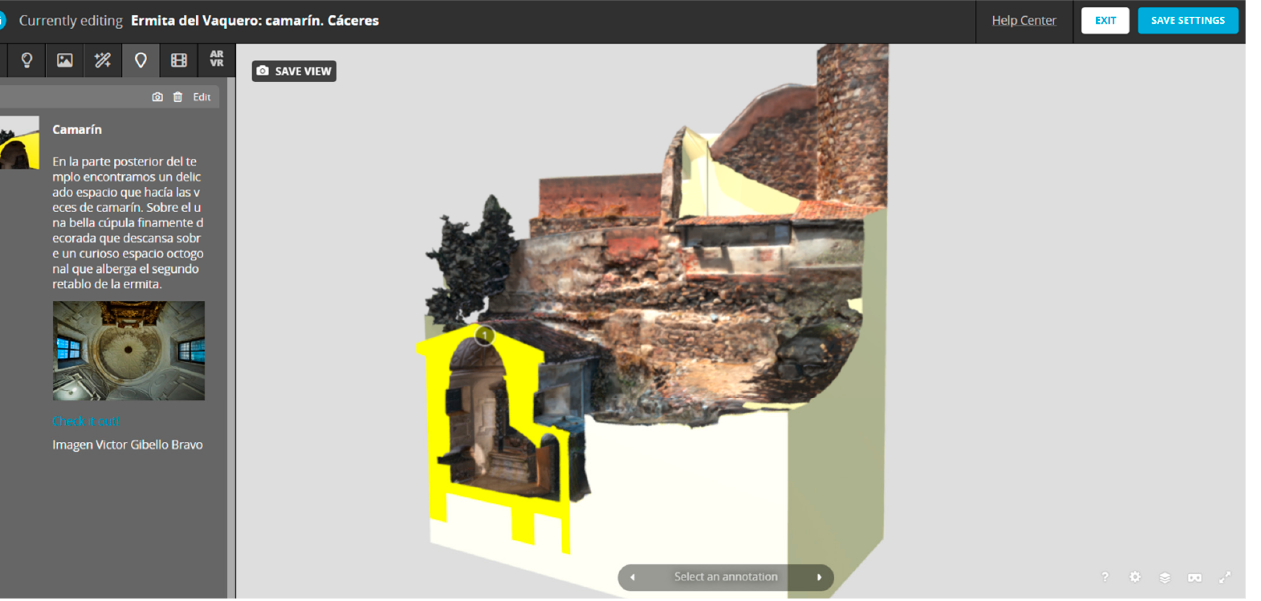
Figure 21. Sketchfab interface. Setting up annotations.